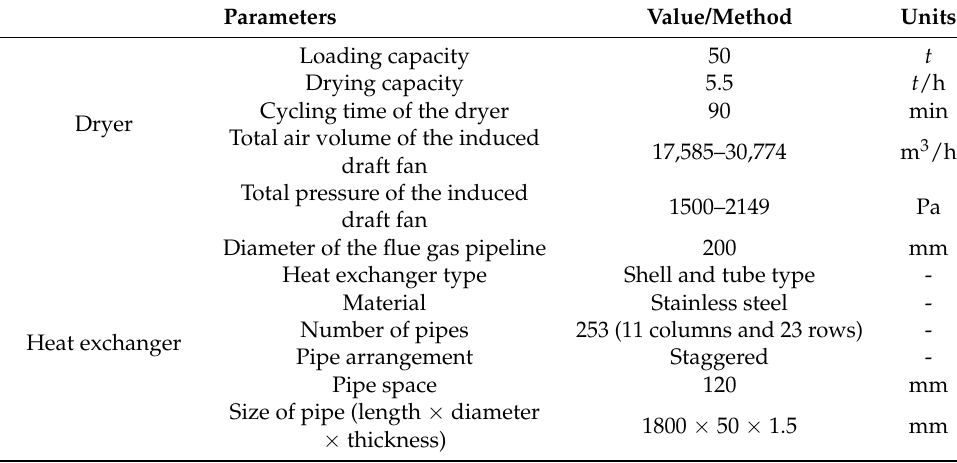
Table 2. The key parameters of the dryer and the heat